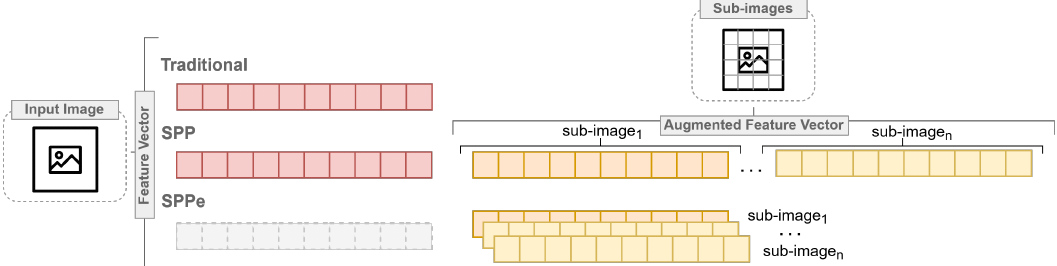
Figure 1. General overview highlighting the differences among traditional, SPP and Spatial Pyramid Partition ensemble (SPPe) approaches of feature vector